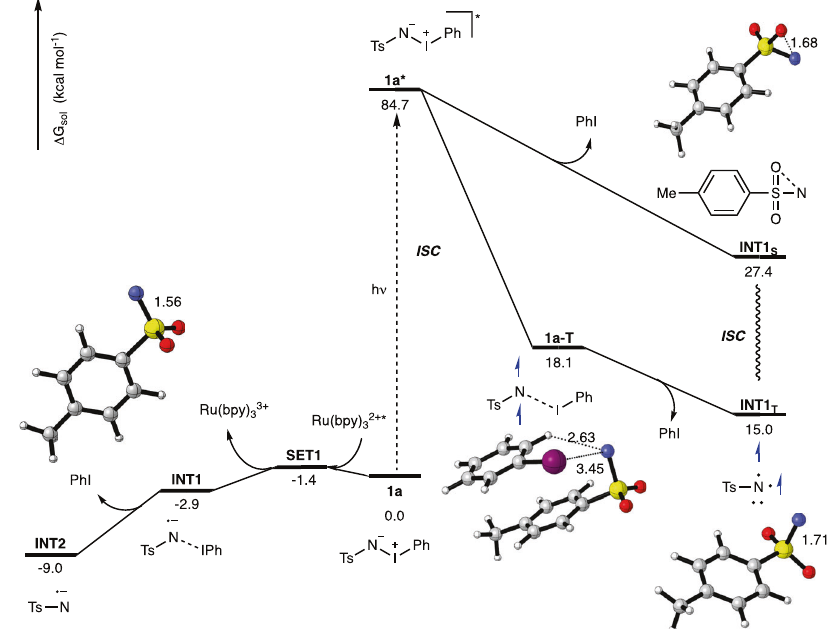
Fig. 3 theoretical calculations on the formation of the nitrene intermediate; calculations were performed at the SMD(DCM)-(U)M06-2X-D3/def2- TZVP//(U)M06-2X-D3/def2-SVP level of theory. Gibbs energies are given in kcal mol − 1